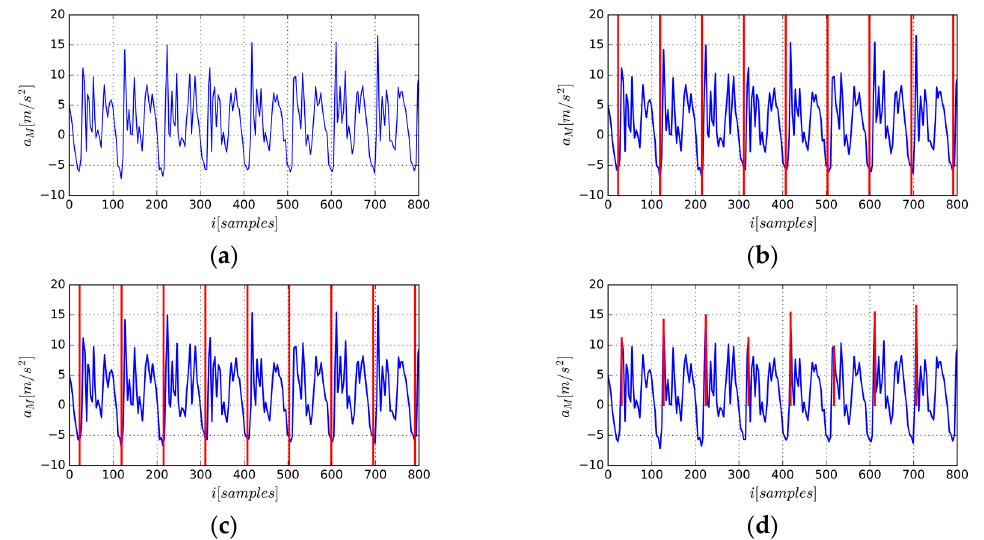
Figure 2. Gait cycle segmentation based on acceleration magnitude time series: ( a ) acceleration magnitude time series; ( b ) equally spaced grid initialization; ( c ) final grid after local searching using greedy strategy; ( d ) corresponding peaks of starting position set of gait cycles, note that there is a “weak” peak in it ensuring gait periodicity.